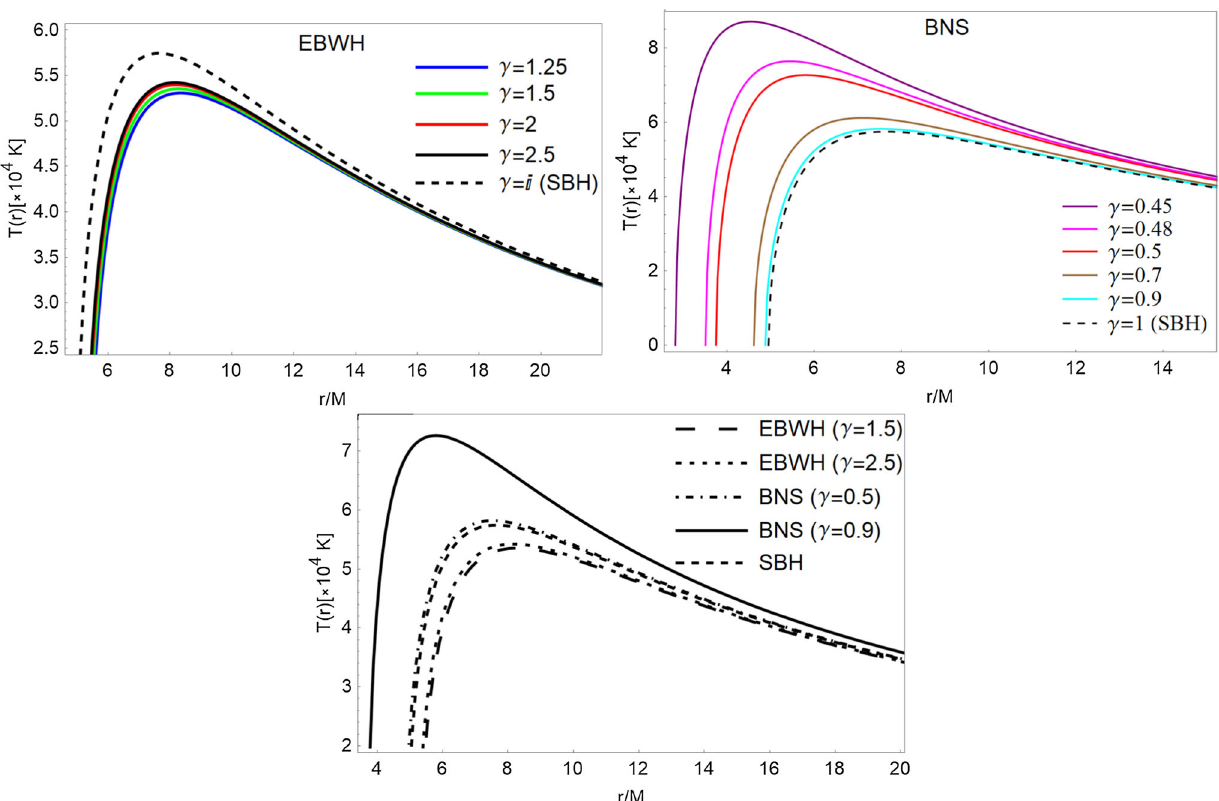
Fig. 6 Temperature distribution T ( r ) of the accretion disk for EBWH, BNS and SBH for different values of